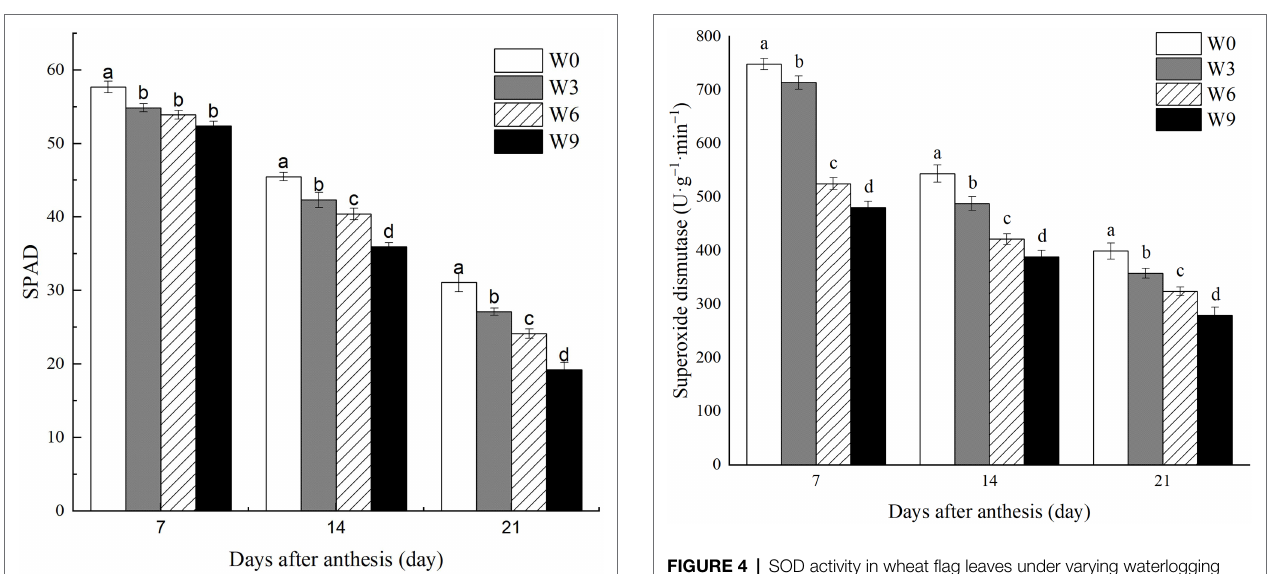
FIGURE 4 | SOD activity in wheat flag leaves under varying waterlogging durations. Data were collected at 7, 14, and 21 days after anthesis. W0 = control, W3 = 3 days of waterlogging, W6 = 6 days of waterlogging, W9 = 9 days of waterlogging. Vertical bars represent the mean of each treatment (six replicates across two years) ± SE (standard errors). Means carrying the same letter are not significantly different at the 5% activity in flag leaves of wheat during all the tested developmental stages ( Figure 4 ). Also, SOD activity under each treatment level gradually decreased with the wheat growth. Compared with their respective control (W0) and averaged across the tested years, W3, W6 and W9 had 4.6, 29.8 and 35.7% lower SOD activity, respectively, at 7 DAA, 10.2, 22.5 and 28.5%, respectively, at 14 DAA and 10.4, 18.9 and 30.1%, respectively at 21 DAA ( Figure 4 ).